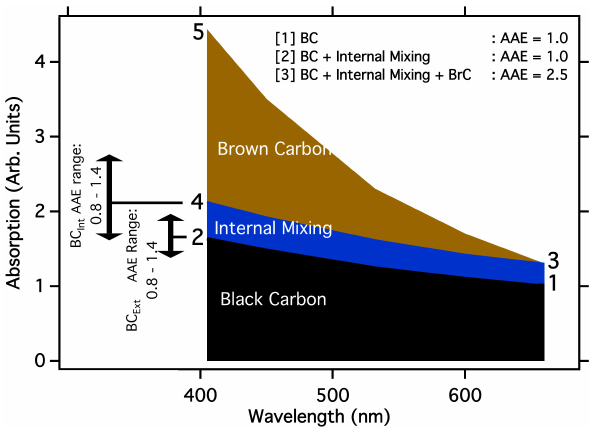
Fig. 1. Illustration of the attribution of absorption using the absorp- tion Ångström exponent. We assume this system does not contain any dust. The absorption by BC Ext is assumed to have an AAE = 1, line 1–2. Absorption by BC internally mixed with non-absorbing material (BC Int ) is often assumed to have an AAE = 1, line 3–4. In this example the AAE of all ambient particles, including brown car- bon, is 2.5, line 3–5. The AAE for BC Ext and BC Int may range from 0.8 to 1.4, which is indicated by the uncertainty arrows on points 2 and